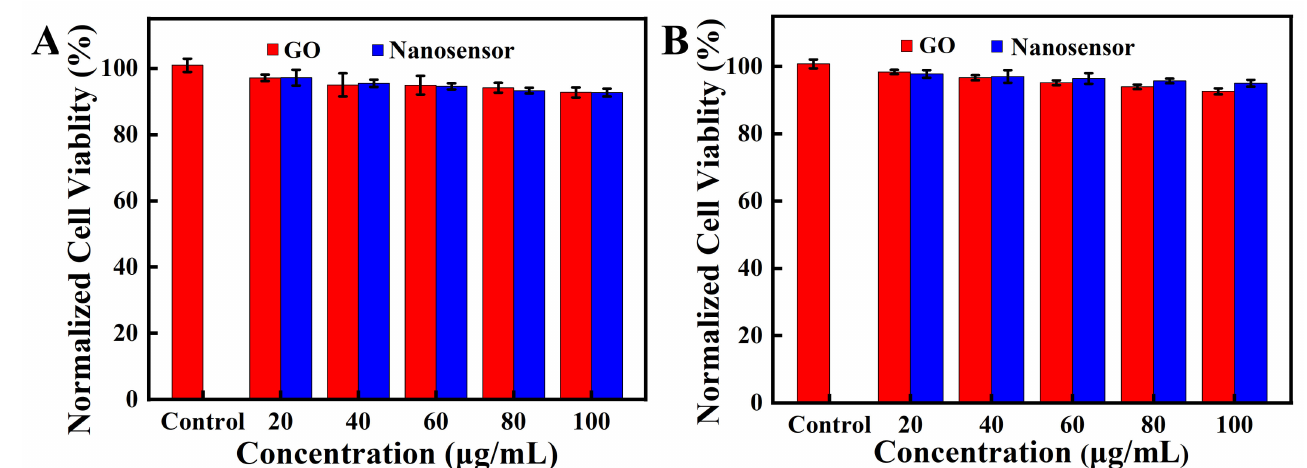
Figure 6. MTT assays of A549 cells ( A ) and Hela cells ( B ). The cells were incubated with various concentrations of GO and the nanosensor for 24